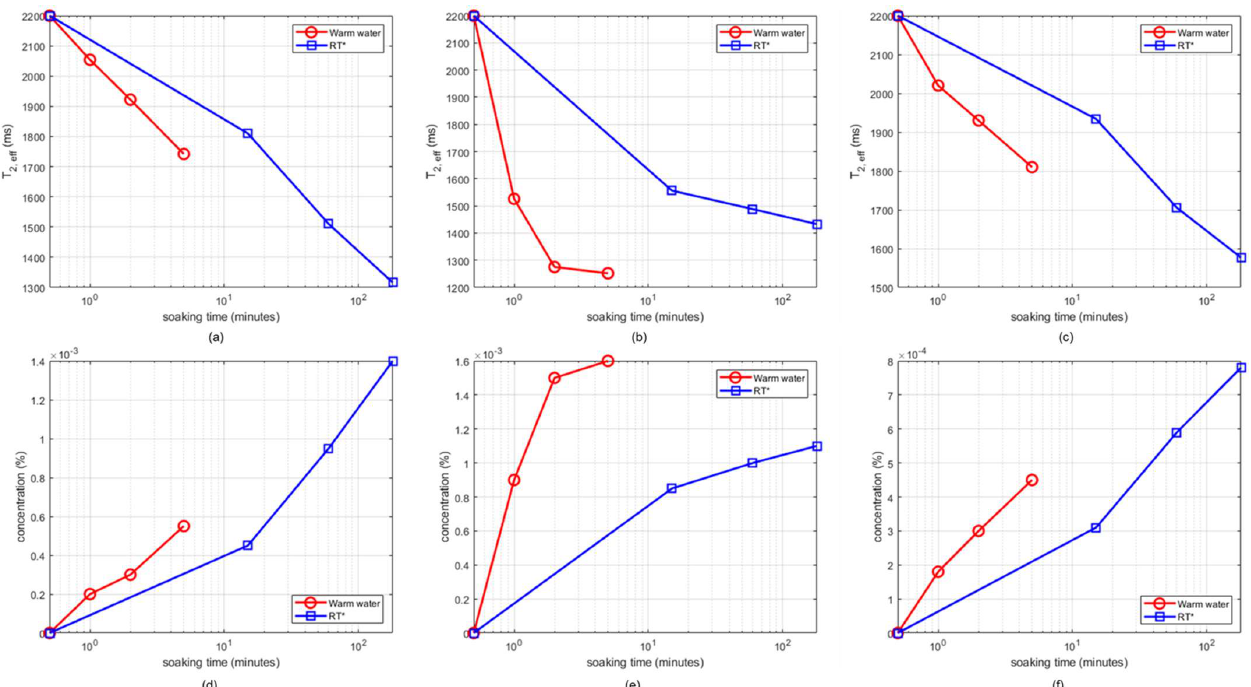
Figure 6. Estimated values of T 2, eff (top row) and concentration of extracted dye in solution (CuSO4, bottom row) as a function of time using water at room temperature and warm water at 60 °C: ( a ), ( d ) pointed gourd; ( b ), ( e ) bitter gourd; and ( c ), ( f ) okra.